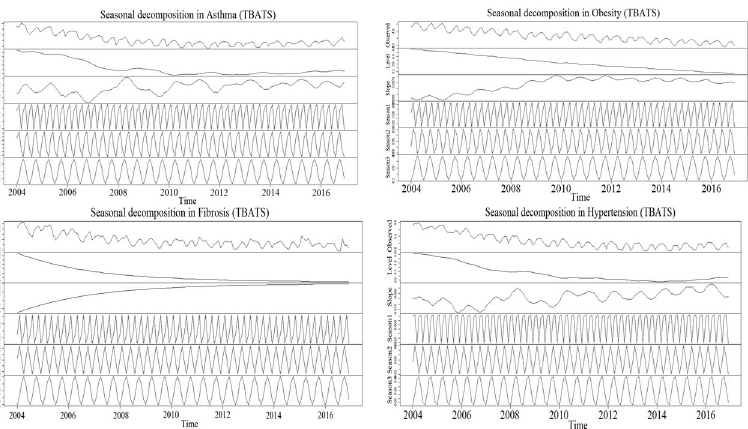
Fig 9. Seasonal and trend decomposition using TBATS for the four group 1 diseases for the monthly collected RSV from Jan 2004–Dec 2016 with obesity as the benchmark disease. Raw observed data were displayed in the top panel as averaged values for all transect points with monthly sampling frequency, followed by level, trend, and seasonal components 1,2, and 3. Scale differs for each of the components, and so relative magnitude was indicated by the gray bars on the left side of the panels.